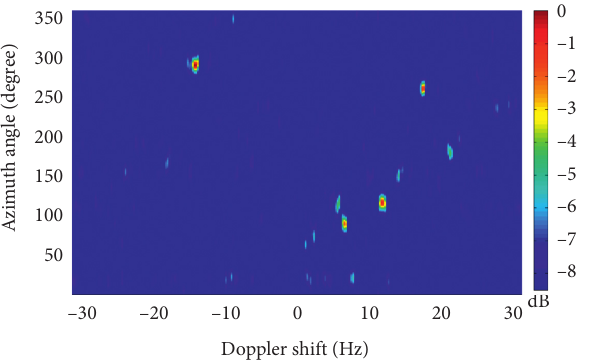
Figure 5: Time-azimuth